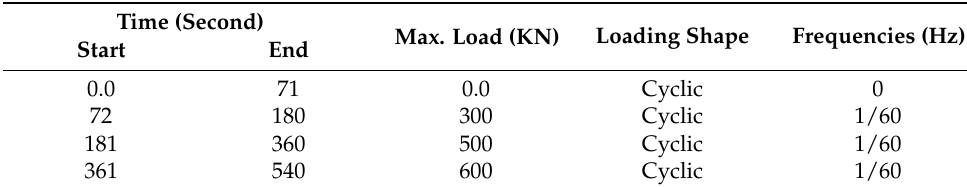
Table 2. Cyclic loading time history.